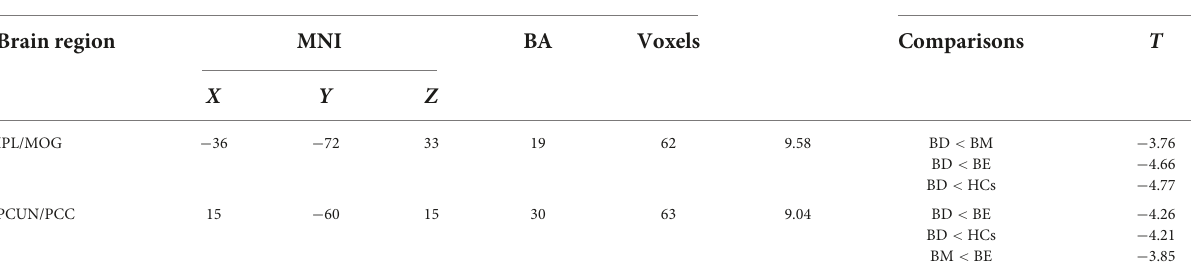
TABLE 2 Brain regions with significant dDC difference among the four groups. One-way ANOVA